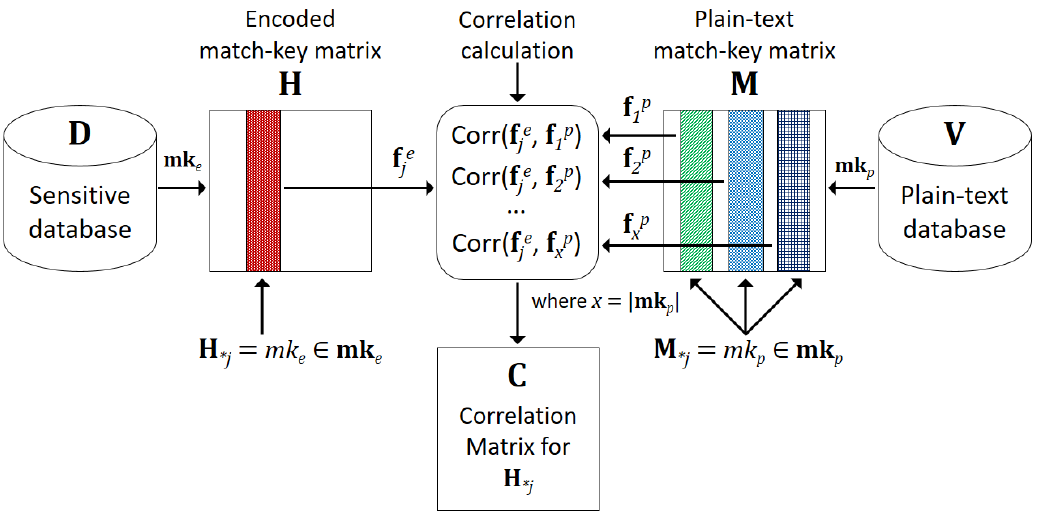
Figure 2: An overview of the first two steps of the proposed privacy attack. We first generate the plain-text match-key matrix, M , and then we calculate the frequency distributions, f je and f jp , of all encoded match-keys H ∈ M . Next, every possible pair of f je and f jp is compared using several correlation metrics. This results in a correlation matrix C for each encoded match-key H *j